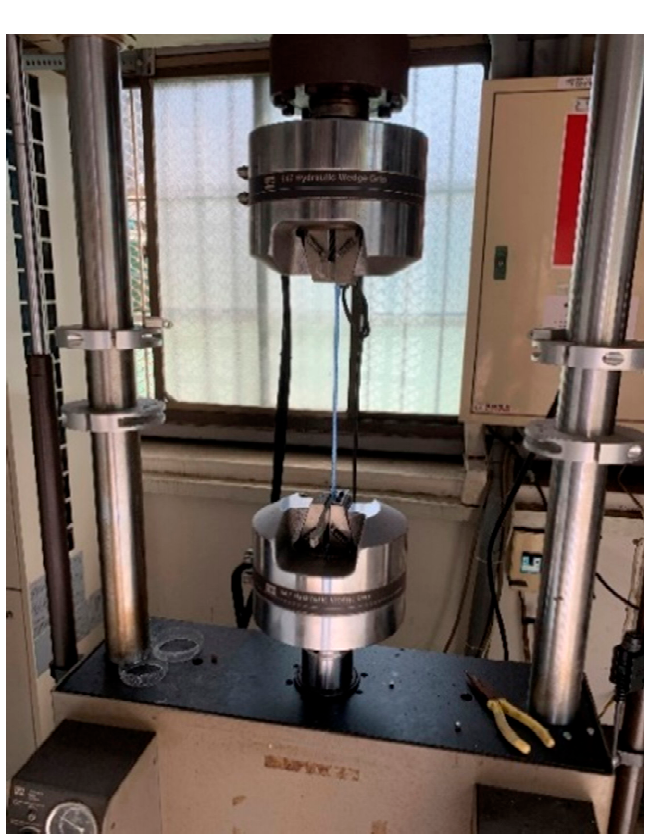
Figure 5. Experimental setup .